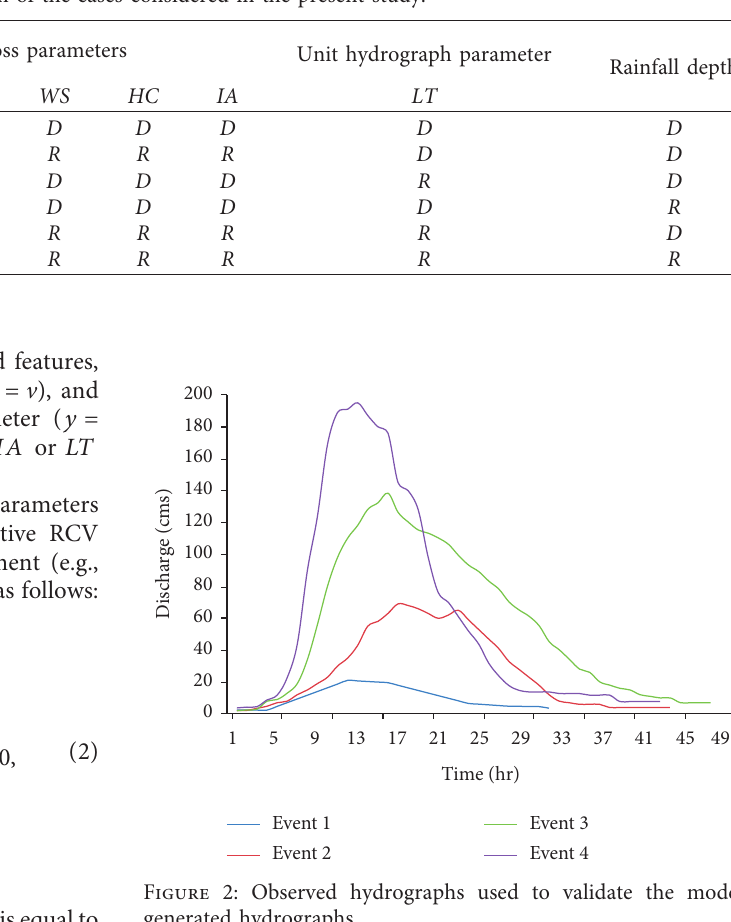
Table 1: Description of the cases considered in the present study.